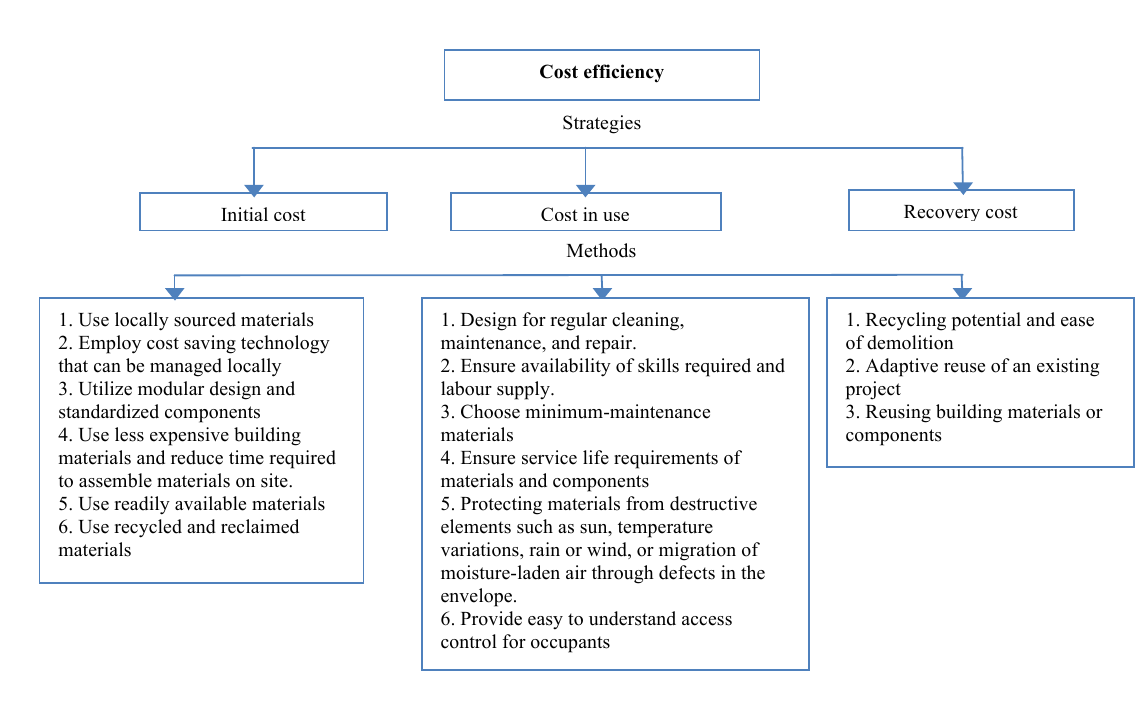
Figure 4. Strategies and Methods to achieve cost